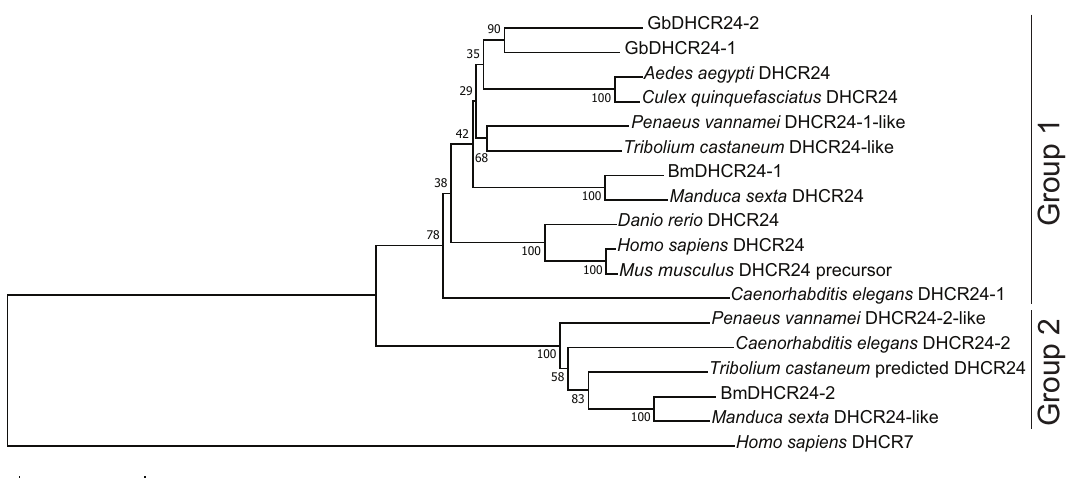
Figure 2. A phylogenetic tree showing the relationship between GbDHCR24 and DHCR24 of other species. Sequences of DHCR24s and related proteins were analysed phylogenetically using the Neighbour Joining method with MEGA X. The numbers next to the branches indicate that the percentage of the same branch was observed in the repeating construction of the phylogenetic tree. The details of the sequences used in the phylogenetic analysis are stated in Table S1. 7-dehydrocholesterol reductase is used as an outgroup in the analysis. The DHCR24 amino acid sequences were split into group 1 and 2.